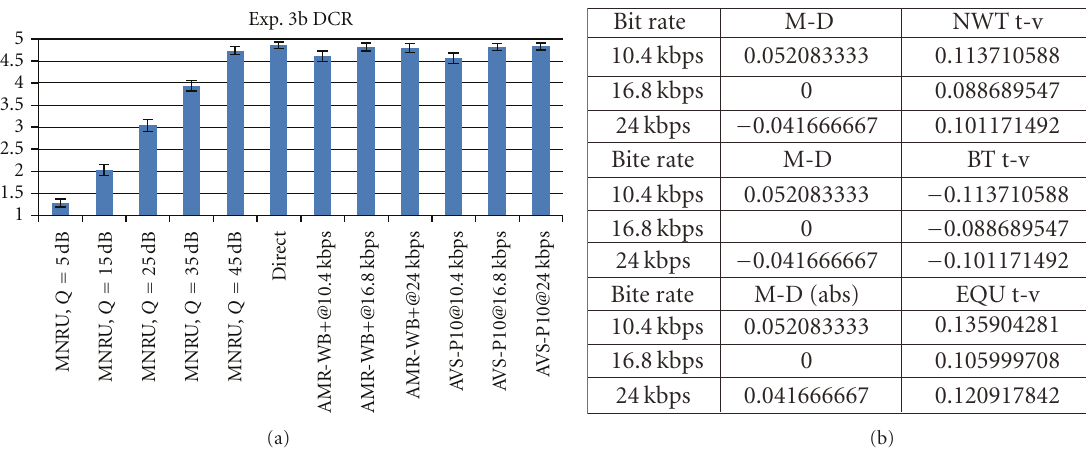
Figure 15: Experiment 3b DMOS scores statistic analysis result and T -test